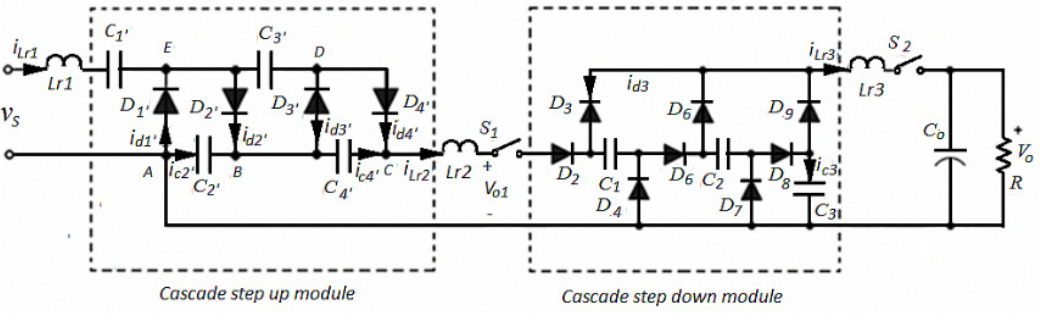
Figure 3. A two step up cell, three step down cell switched capacitor AC-DC